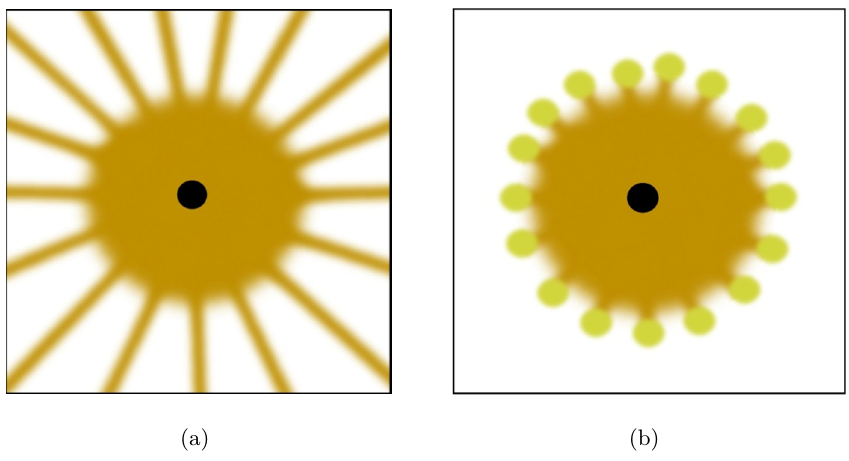
Figure 3 . (a) Hairy magnetic black hole in the abelian Higgs model with a central region where the Higgs field is small and an outside region where it forms vortex strings. (b) Once we add the SU(2) gauge fields, the vortex strings can end on